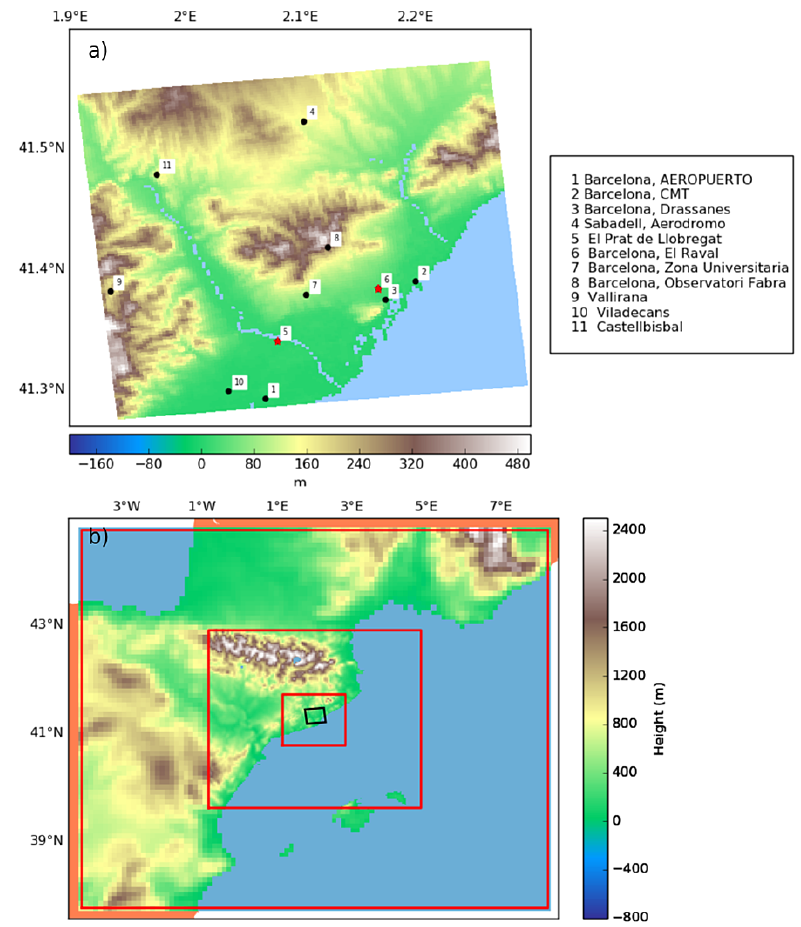
Figure 1. (a) Topography of the UrbClim domain and locations of the meteorological stations. The two stations used as a reference of the urban and rural climates are highlighted with red stars. (b) Three WRF domain edges (red squares) and UrbClim domain edges (black contour), together with the topography of the WRF domains with 10, 3.3 and 1.1km